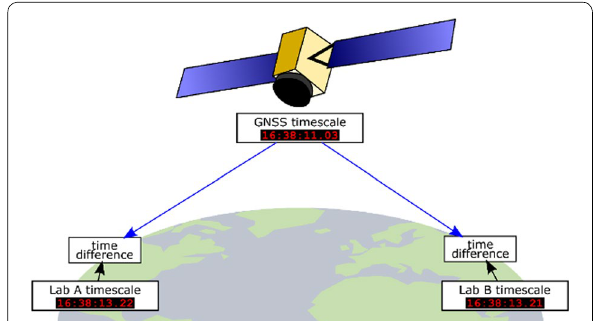
Fig. 4 Principle of the GNSS time